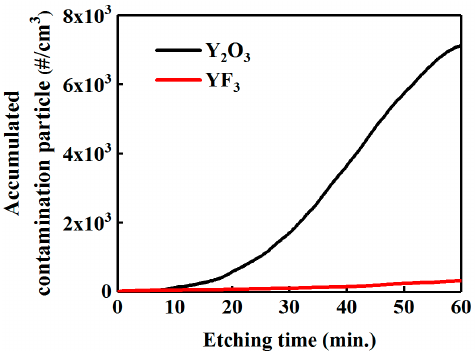
Figure 7. Real-time detection of accumulated contamination particle concentration, over 0.2 µm size, generated from Y 2 O 3 and YF 3 during the 60 min NF 3 plasma treatment.